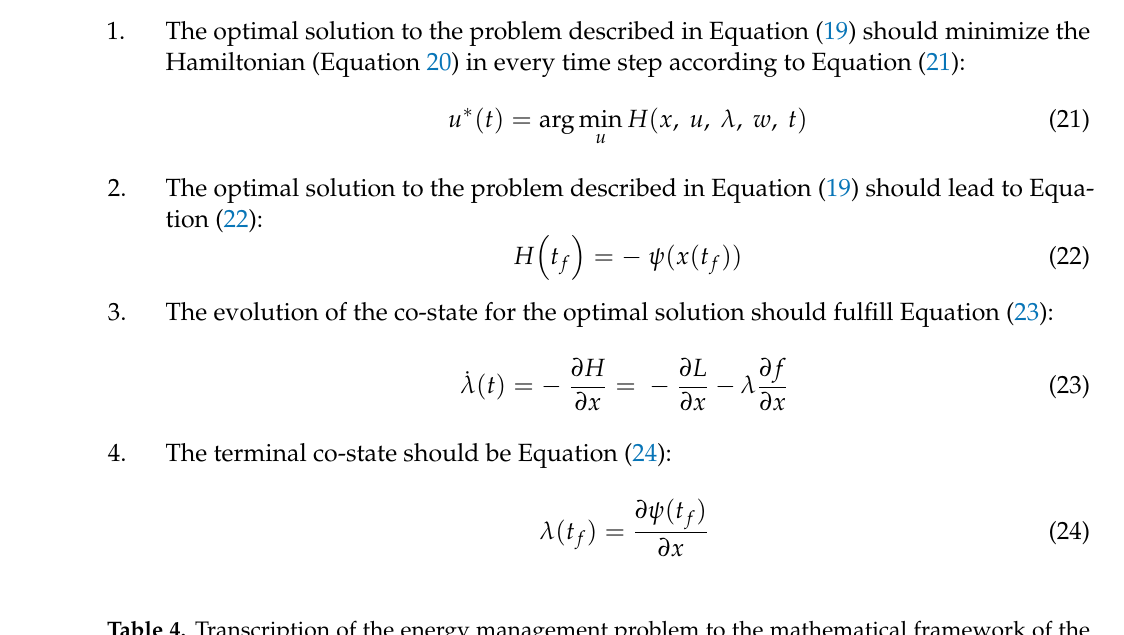
Table 4. Transcription of the energy management problem to the mathematical framework of the optimal